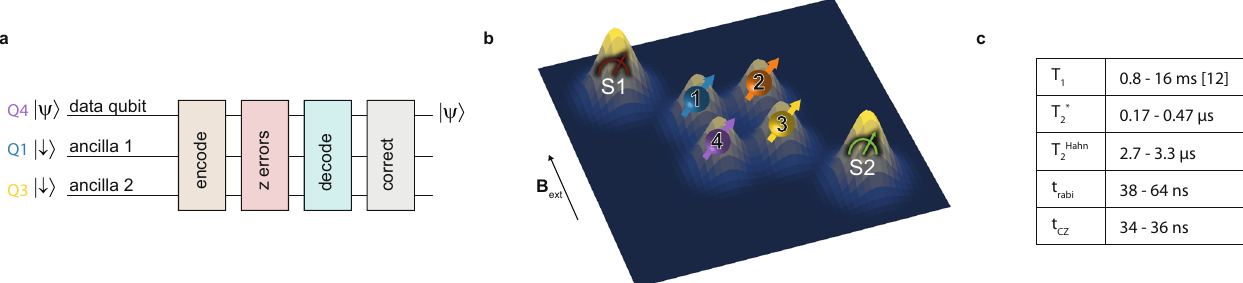
Fig. 1 Error-correction circuit diagram and properties of the four-spin qubit register. a Quantum error correction circuit using one data qubit and two ancilla qubits. Qubits are encoded to a logical state (beige) in which they are resilient against single-qubit phase errors (soft red), since these errors result in distinct states of the ancilla qubits which, after the decoding (turquoise), can be used to correct the data qubit (gray). b Schematic drawing giving an impression of the electrostatic potential of the quantum device. Using electrostatic potentials on metallic gates, four quantum dots are de fi ned, each containing a single hole spin qubit. The qubits are indicated with a color: qubit 1 (Q1) in blue, qubit 2 (Q2) in orange, qubit 3 (Q3) in yellow and qubit 4 (Q4) in purple. The spin states are read out by spin-to-charge-conversion using latched Pauli spin blockade using the two charge sensors, S1 and S2, indicated in red and green respectively. c Table showing the relevant time scales of the four qubits used in this work. The spin relaxation time is measured on the same device but at a higher magnetic fi eld 26